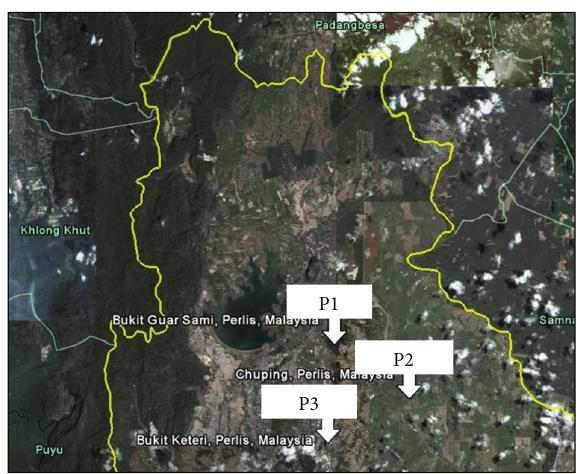
Figure 1: Dolomite quarries locations in Perlis